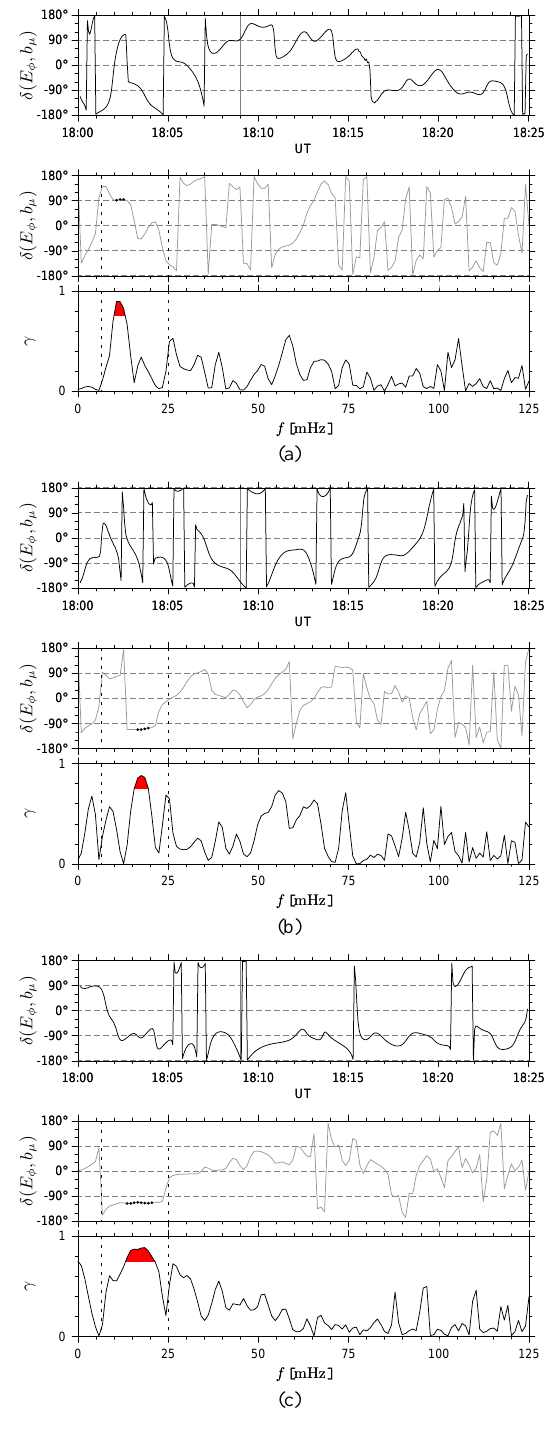
Fig. 7: Coherence and phase difference between b µ and Fig. 7. Coherence and phase difference between b µ and E φ at (a) E φ at (a) C1, (b) C2 and (c) C4. The shaded portions C1, (b) C2, and (c) C4. The shaded portions of the coherence curves of the coherence curves indicate frequencies for which γ indicate frequencies for which γ exceeds the threshold of 75%, and exceeds the threshold of 75%, and at these frequencies at these frequencies solid points are plotted for the phase solid points are plotted for the phase difference.